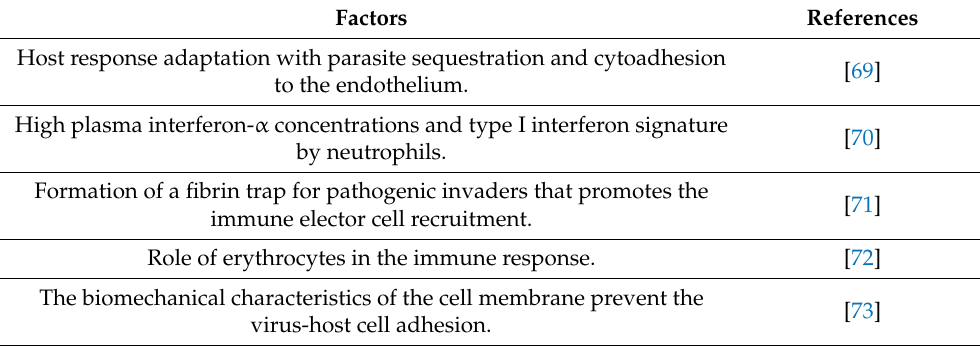
Table 5. Factors that may play a role in adapting the immune response of SCD patients to COVID-19. Factors Host response adaptation with parasite sequestration and cytoadhesion to the endothelium. High plasma interferon- α concentrations and type I interferon signature by neutrophils. Formation of a fibrin trap for pathogenic invaders that promotes the immune elector cell recruitment. Role of erythrocytes in the immune